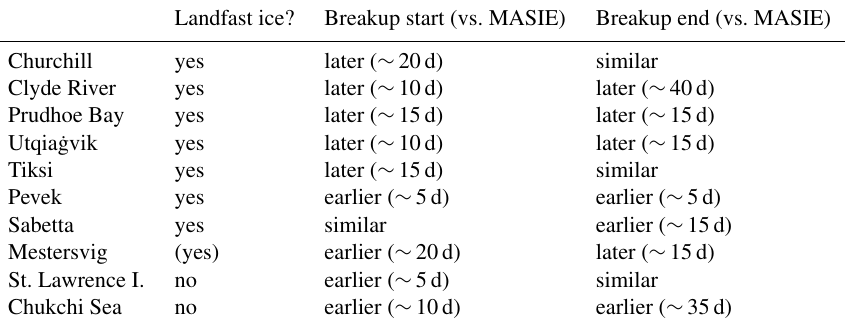
Table 5. Summary of landfast ice presence at each coastal site and timing of breakup at the site relative to breakup in corresponding MASIE region (Figs. 10 and 11).